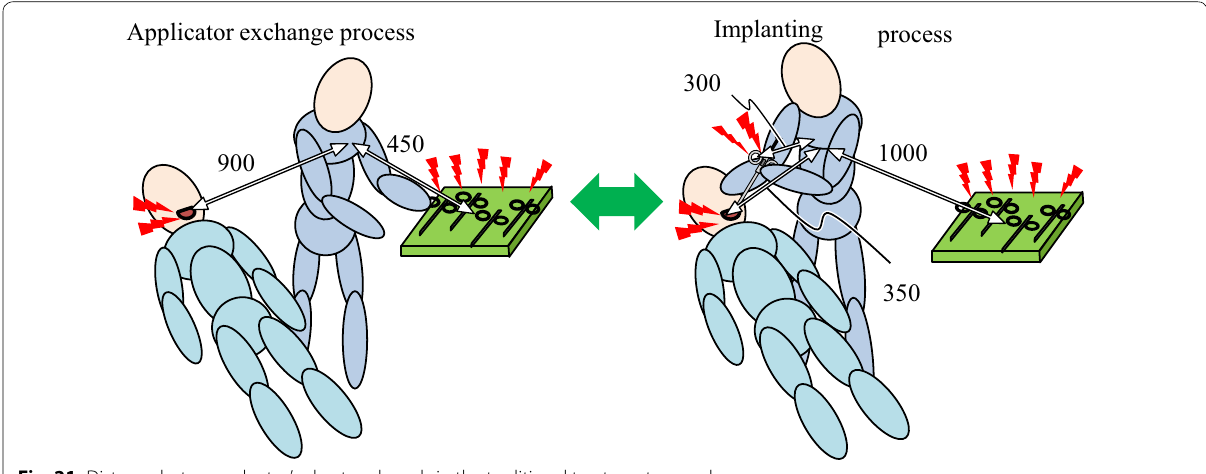
Fig. 21 Distance between doctor’s chest and seeds in the traditional treatment procedure